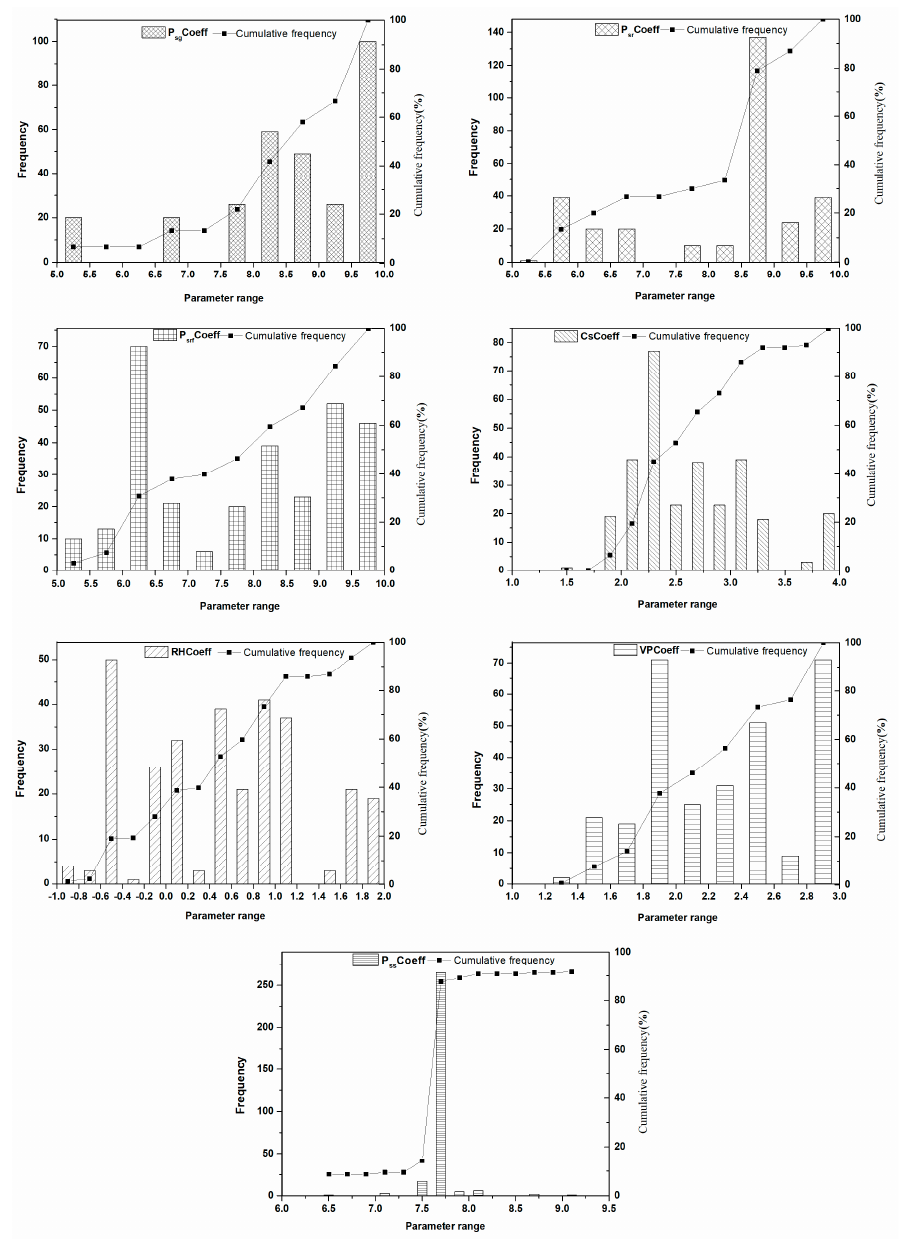
Figure 3. Frequency distribution and cumulative frequency of top ranking parameters in first calibration step.